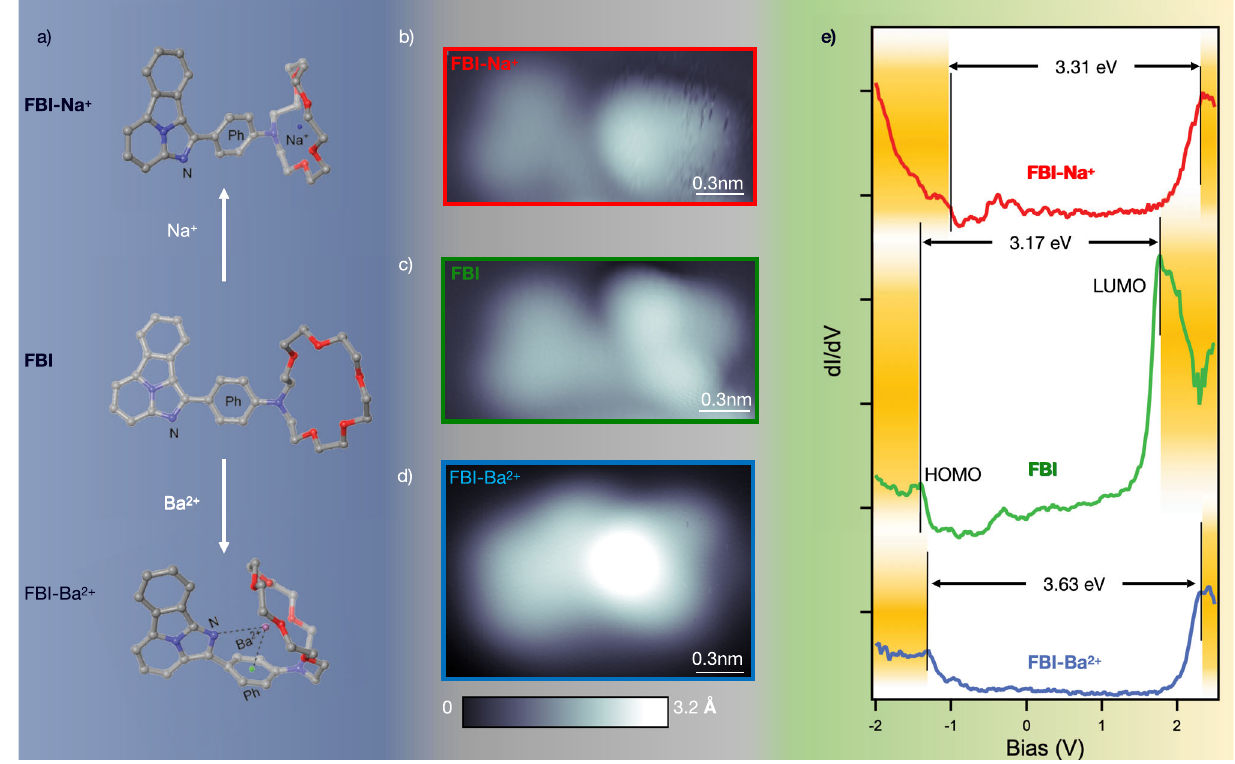
e STS spectra of pristine (green), Na + -complexed (red), and Ba +2 -complexed FBI (blue)FBI. Extra spectra for unchelated and chelated molecules are shown in Supplementary Fig.